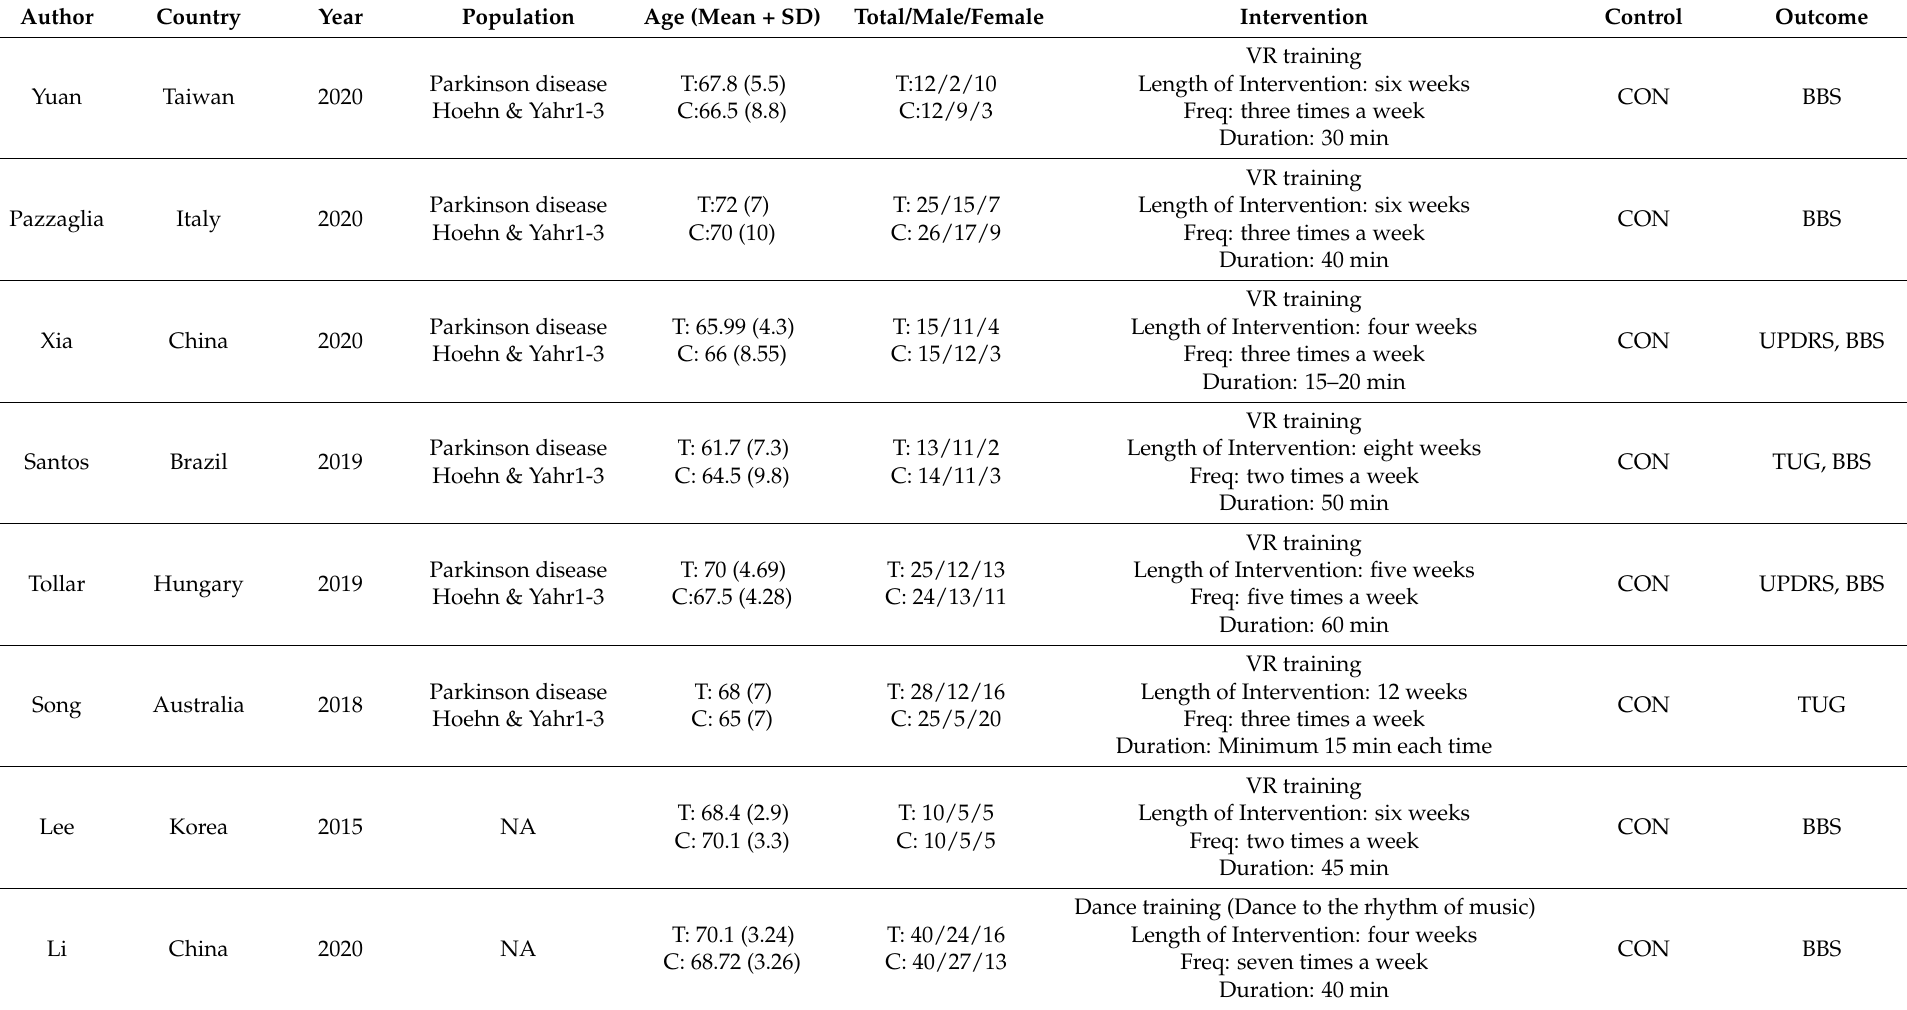
Table 2. Characteristics of the studies included in the